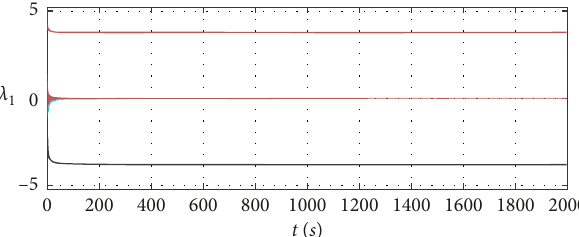
Figure 8: Three most relevant Lyapunov exponents to nonideal loaded manipulator.